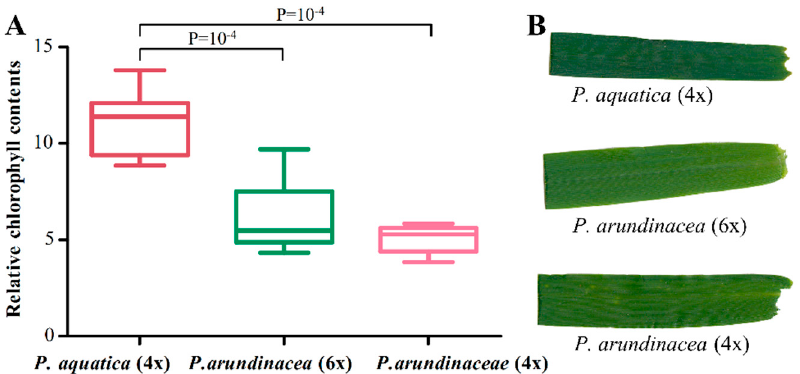
Figure 7. Comparison of the relative chlorophyll content of the leaves ( A ) and the leave color ( B ) of three Phalaris cultivars.